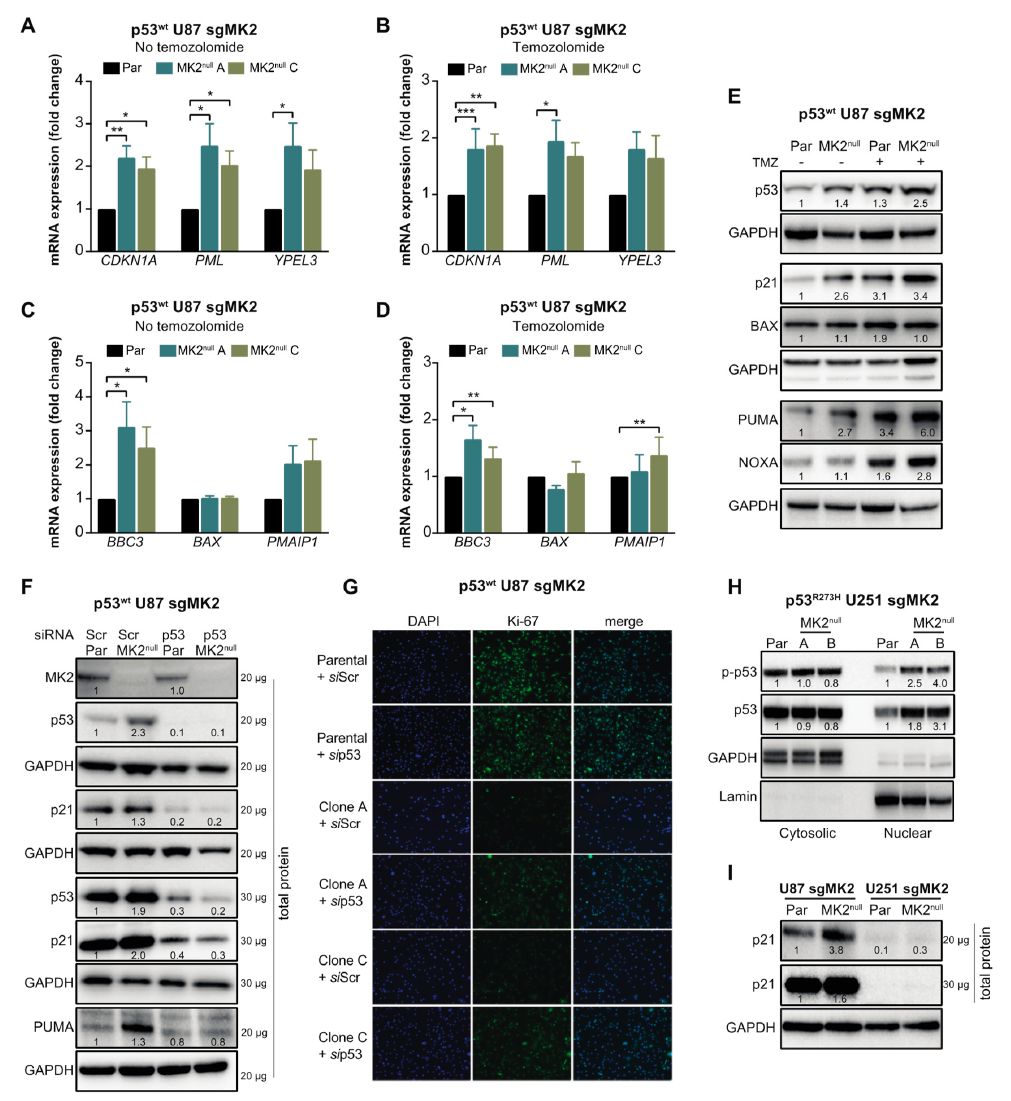
Figure 5. p53 wt silencing rescues the anti-proliferative efficacy of MK2 inhibition. ( A–D ) Parental (Par) cells and MK2 null clones were treated with temozolomide (TMZ, 50 μ M, 48 hr) and nuclear extracts analyzed by qRT-PCR for senescence ( A,B ) and apoptosis ( C,D ) genes. Bar graphs represent mean ± SEM from 3 independent experiments (* p < 0.05; ** p < 0.01; *** p < 0.001; paired t-test). ( E ) Parental and MK2 null (clone A) cells were treated with temozolomide (50 μ M, 48 hr) and lysates immunoblotted against indicated antibodies . ( F ) Parental and MK2 null (clone A) cells were transfected with scramble (Scr) or p53 siRNA for 72 hr, and lysates immunoblotted against indicated antibodies. ( G ) Parental and MK2 null (clones A and C) cells were transfected with scramble or p53 siRNA for 72 hr. Fixed cells were stained with Ki67 antibody and DAPI. ( H ) Cytosolic and nuclear extracts of parental and MK2 null (clones A and B) cells were immunoblotted against indicated antibodies. ( I ) Lysates of parental and MK2 null (clone A for U87; clone A for U251) cells were immunoblotted against indicated antibodies. All immunoblots including band intensities and immunofluorescence images are representatives of 3 independent experiments.